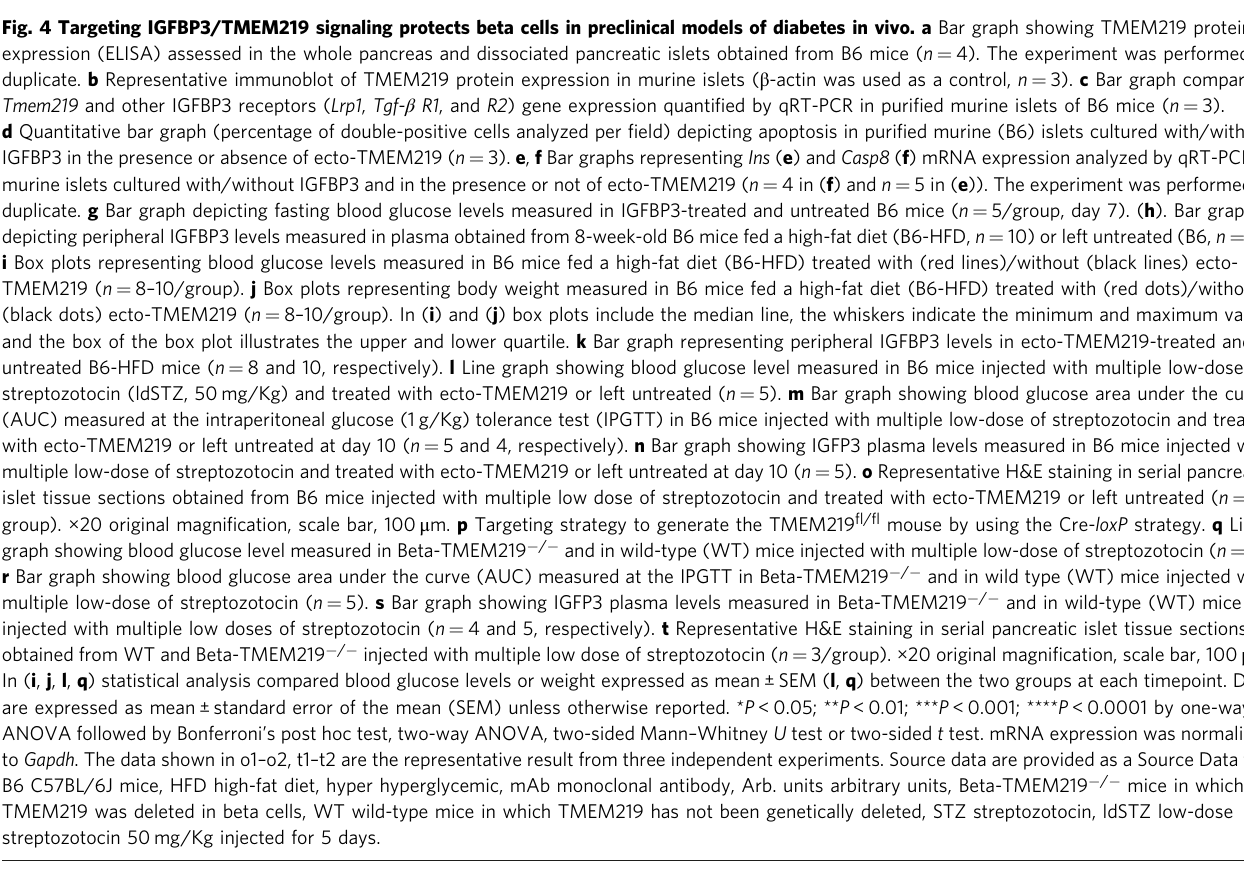
Fig. 4 Targeting IGFBP3/TMEM219 signaling protects beta cells in preclinical models of diabetes in vivo. a Bar graph showing TMEM219 protein expression (ELISA) assessed in the whole pancreas and dissociated pancreatic islets obtained from B6 mice ( n = 4). The experiment was performed in duplicate. b Representative immunoblot of TMEM219 protein expression in murine islets ( β -actin was used as a control, n = 3). c Bar graph comparing Tmem219 and other IGFBP3 receptors ( Lrp1 , Tgf- β R1 , and R2 ) gene expression quanti fi ed by qRT-PCR in puri fi ed murine islets of B6 mice ( n = 3). d Quantitative bar graph (percentage of double-positive cells analyzed per fi eld) depicting apoptosis in puri fi ed murine (B6) islets cultured